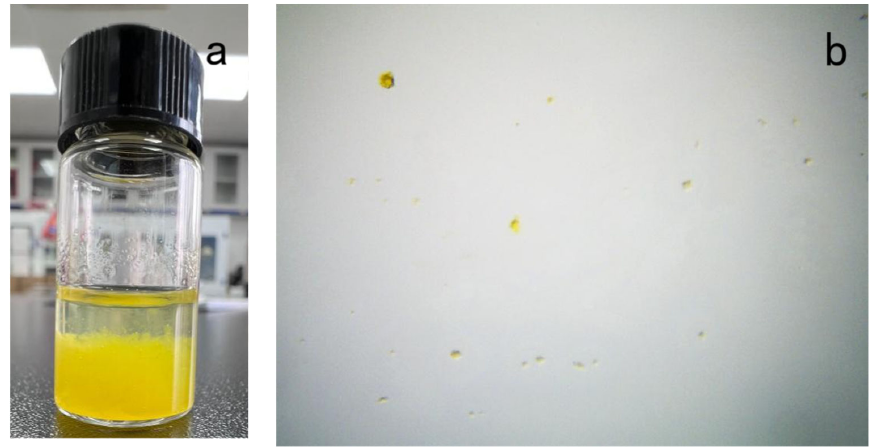
Figure 6. The macroscopic ( a ) and microscopic ( b ) morphology of the microcapsule suspension.